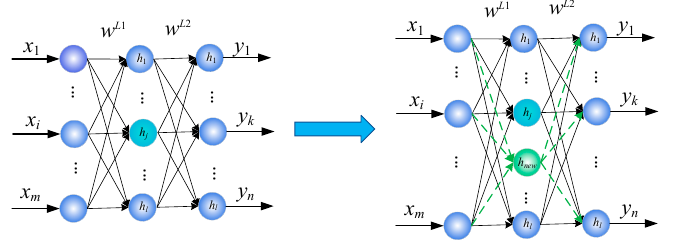
Figure 7. The SOFNN neuron growth process. In Figure 7, h out is the output neuron in the regular layer, and T denotes the total number of learning samples. For a large number of samples or online learning, T is obtained using a sliding window.